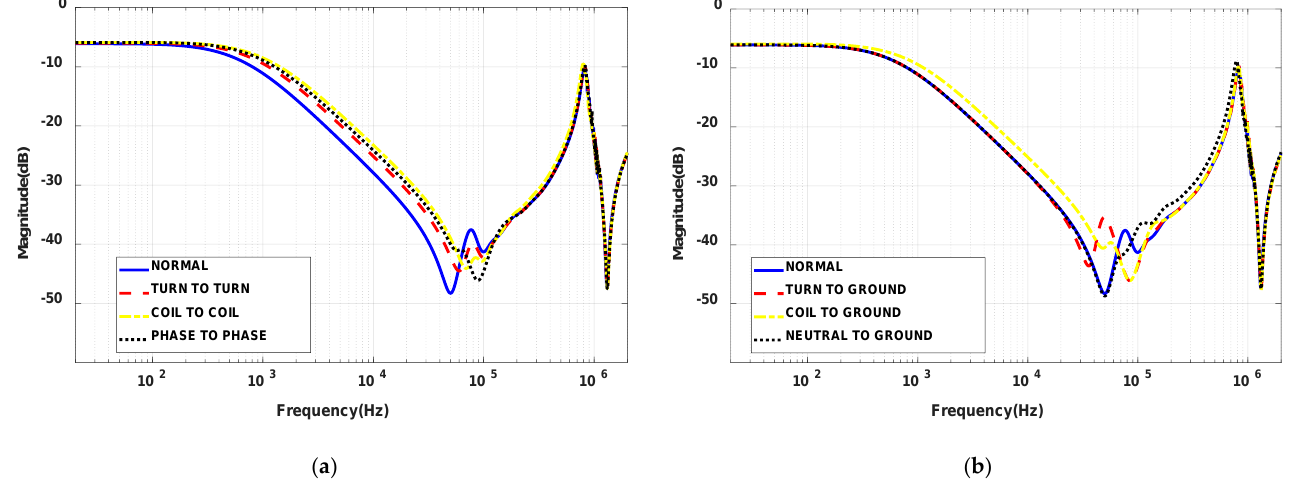
Figure A1. U–N FRA measured responses for the tested IM with stator star connection for ( a ) Normal vs turn − to − turn, coil − to − coil, and phase − to − phase SC fault ( b ) Normal vs turn − to − ground, coil − to − ground, and neutral − to − ground SC faults.